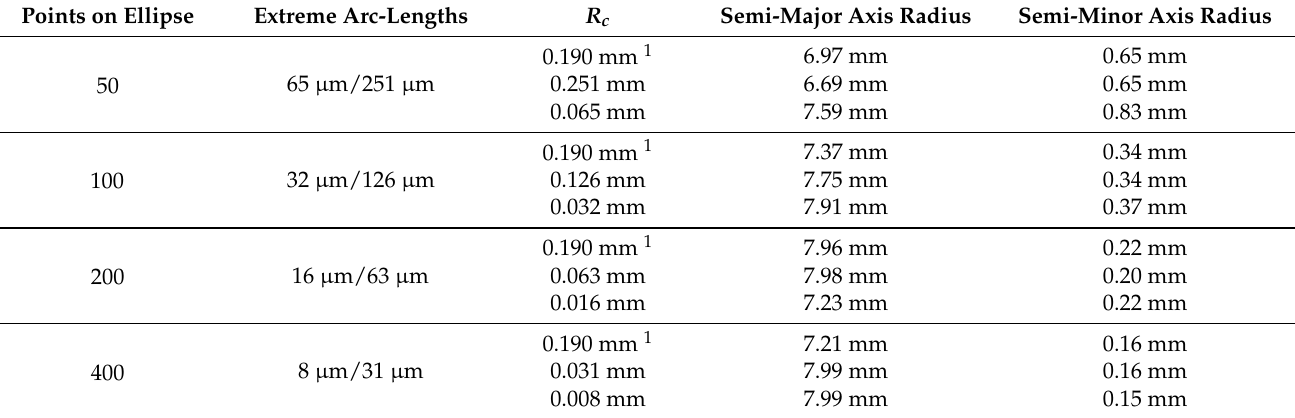
Table 3. Effect of mesh-seed and control radius on computed curvature for elliptical hole-in-plate (refer to Figure